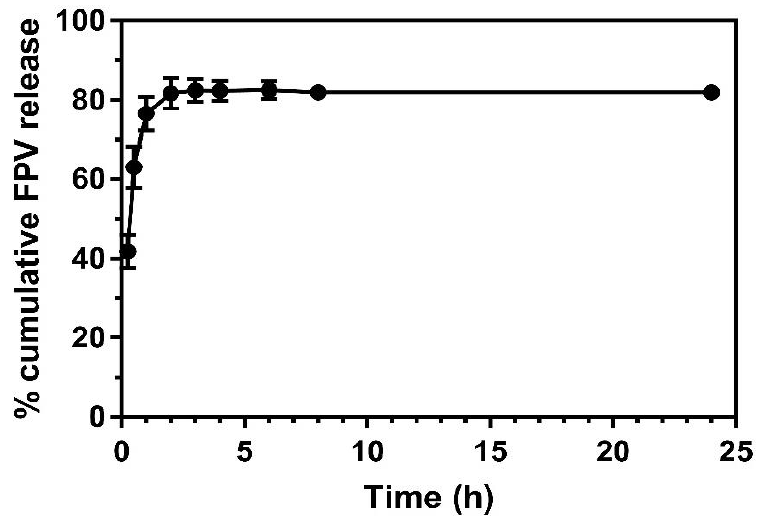
Figure 2. In vitro drug release across a dialysis membrane of FPV-SLNs ( n = 3, mean ± SD).